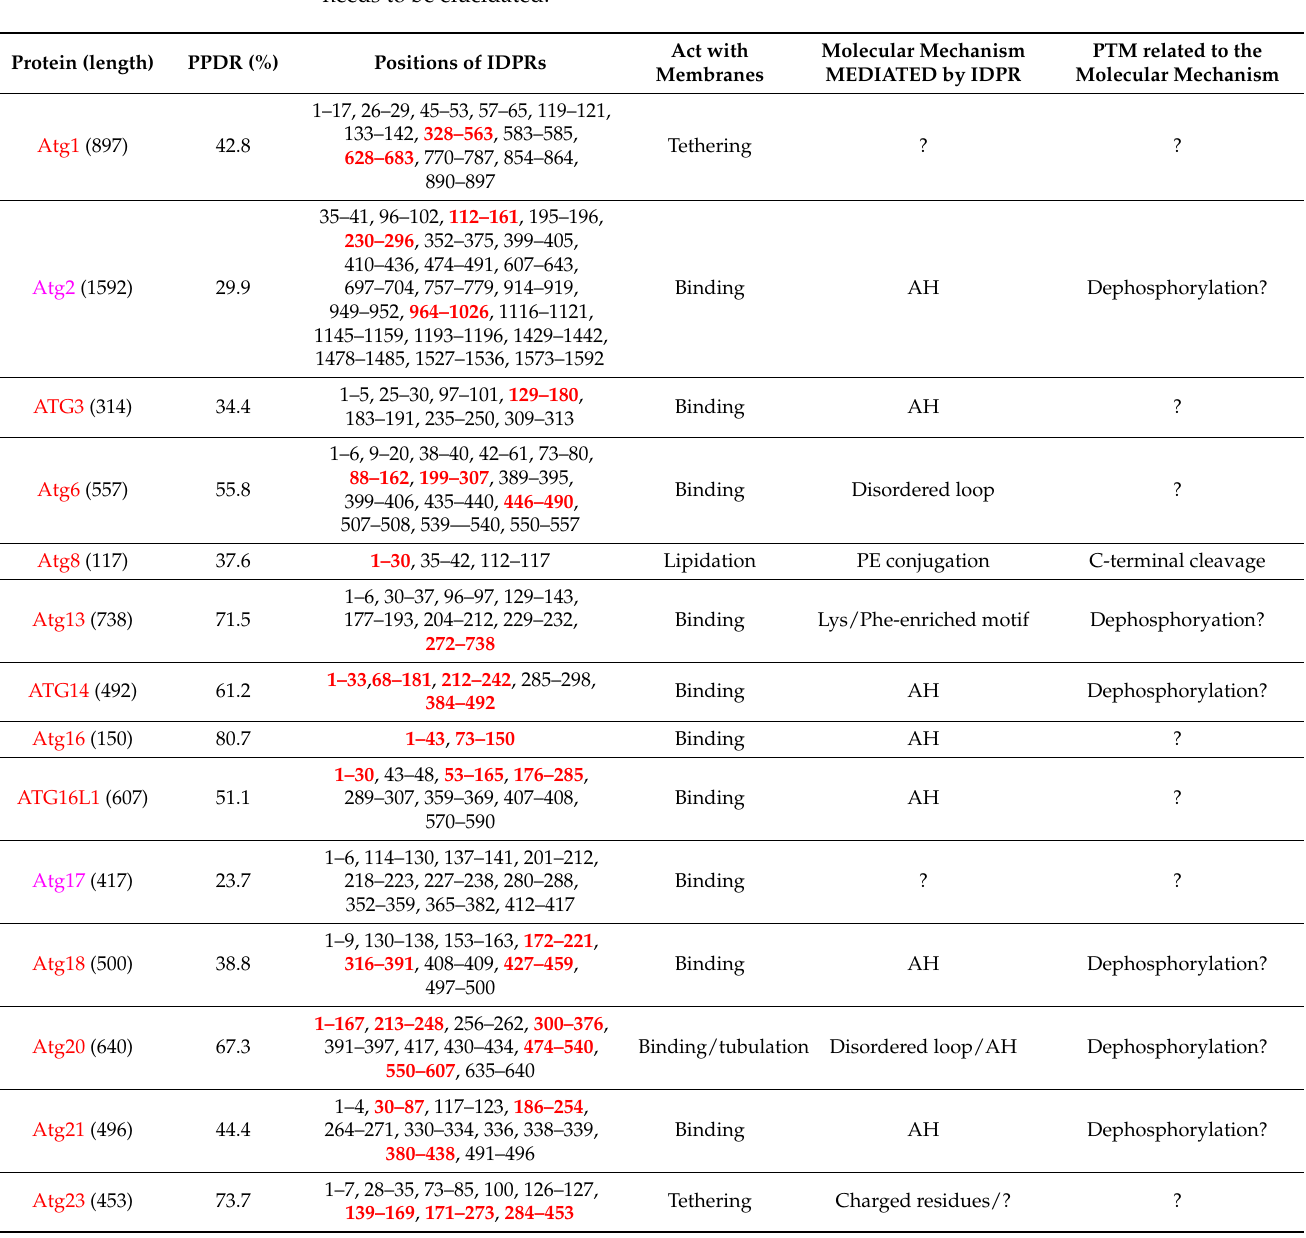
Table 1. Autophagy proteins engaging their intrinsically disordered protein regions (IDPRs) in actions on membranes via various molecular mechanisms. The percent of predicted disordered residues (PPDR) defines the proteins as highly ordered (PPDR < 10%), moderately disordered (10% ≤ PPDR < 30%), or highly disordered (PPDR ≥ 30%). Note that none of the analyzed proteins could be classified as highly ordered. PPDR values were retrieved from the results of PONDR ® VSL2 analysis. Names of moderately and highly disordered proteins are shown by pink and red font, respectively. Long IDPRs (i.e., IDPRs containing at least 30 residues) are shown by the bold red font. The question mark represents an unknown or putative mechanism/posttranslational modification (PTM) that needs to be